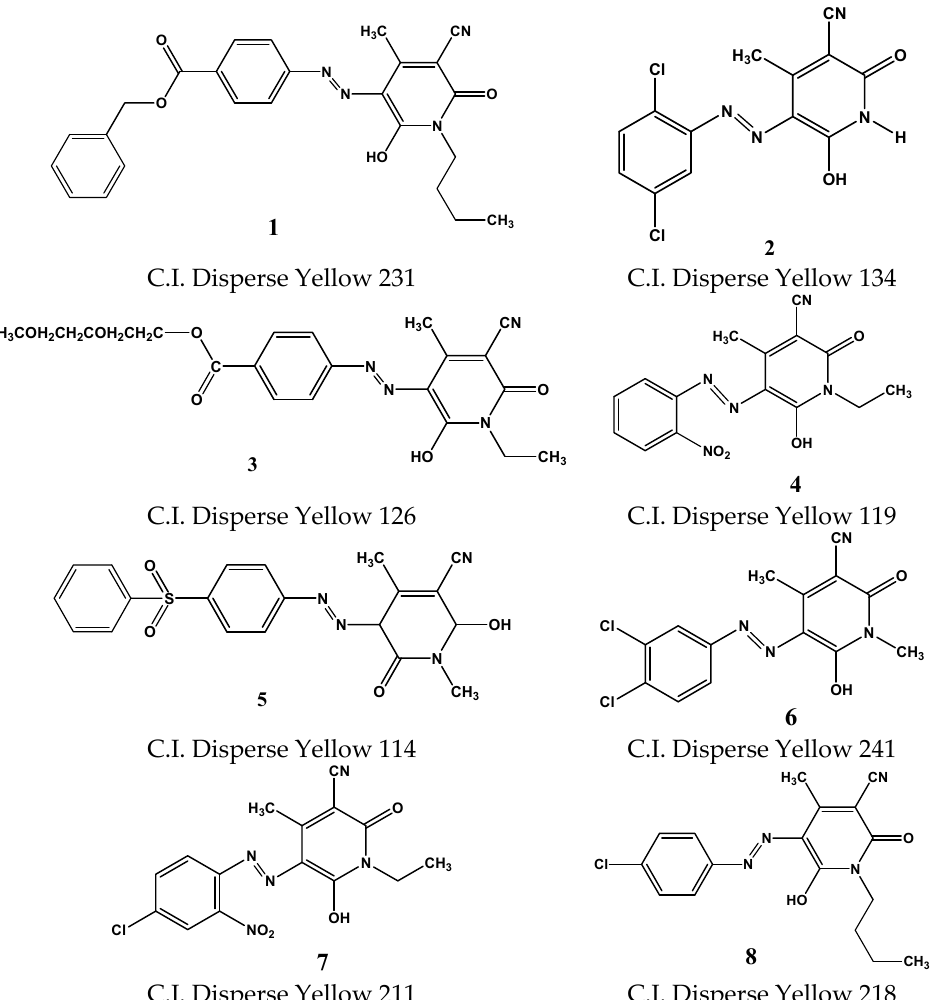
Figure 1. Some of the commercial dyes.